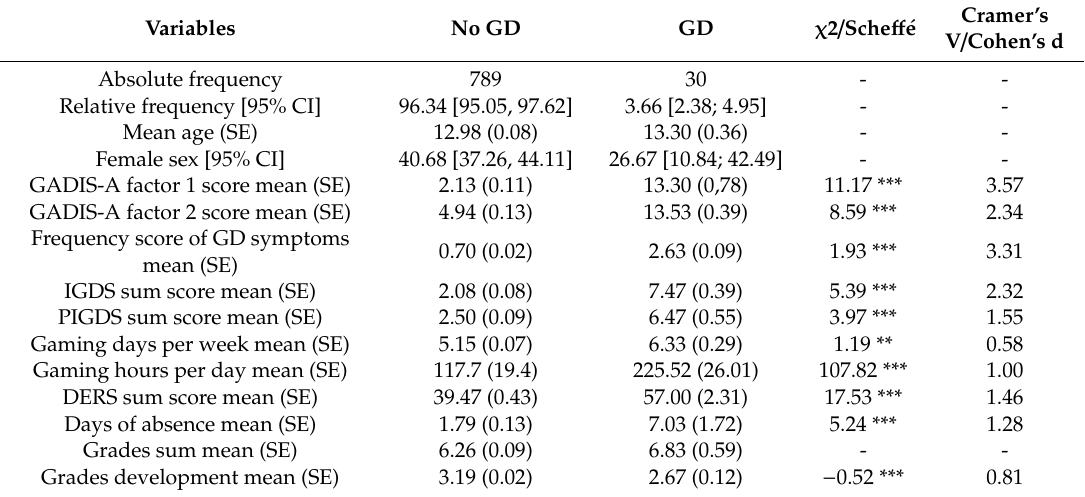
Table 6. Post-hoc MANOVA and between groups tests in GD / Non-GD adolescents according to ROC-cut o ff s and time criterion (GD symptoms during the past year at least for longer periods or daily). Variables No GD GD χ 2 / Sche ff